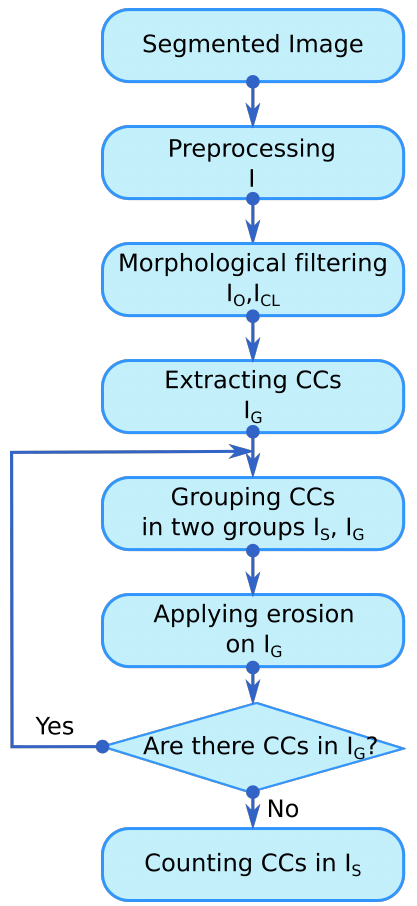
Figure 7. Flow chart of the implemented agave counting algorithm based on mathematical morphology: the abbreviation CC stands for connected component. The grouping step is carried out by a thresholding method. The segmented image is the output of the proposal in